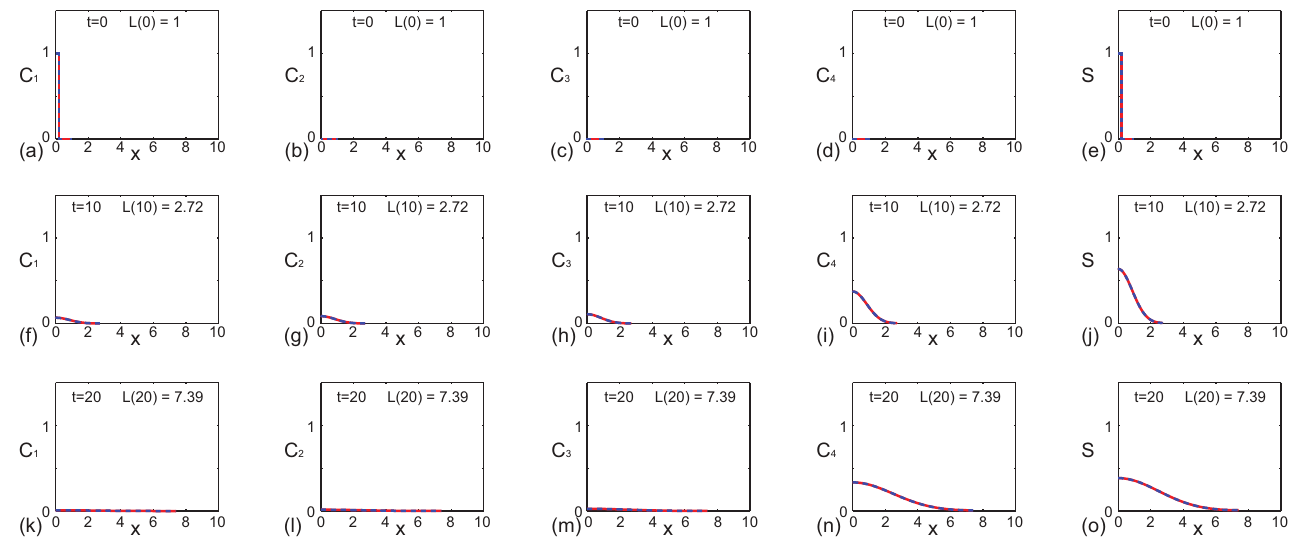
Fig 3. Comparison of exact and numerical solutions of Eqs (12) – (15) with distinct reaction rates where colonization occurs occur by t = 20. Profiles in (a) – (e), (f) – (j) and (k) – (o) show C 1 ( x , t ), C 2 ( x , t ), C 3 ( x , t ), C 4 ( x , t ) and S ( x , t ) at t = 0,10, and 20, respectively. Each subfigure shows the exact solution (solid red) superimposed on the numerical solution (dashed blue). This example corresponds to exponential domain growth with L (0) = 1, L (10) = e (cid:5) 2.78 and L (20) = e 2 (cid:5) 7.39, as indicated in each subfigure. The exact solutions are obtained by truncating the infinite series after 1000 terms and the numerical solutions (S1 Supporting Information) correspond to δξ = δ t = 1 × 10 − 3 . Here we have L (0) = 1, α = 0.1, C = 1, γ = 0.2, D = 1 × 10 − 2 , k 1 = 0.1, k 2 = 0.2, k 3 = 0.3 and k 4 =